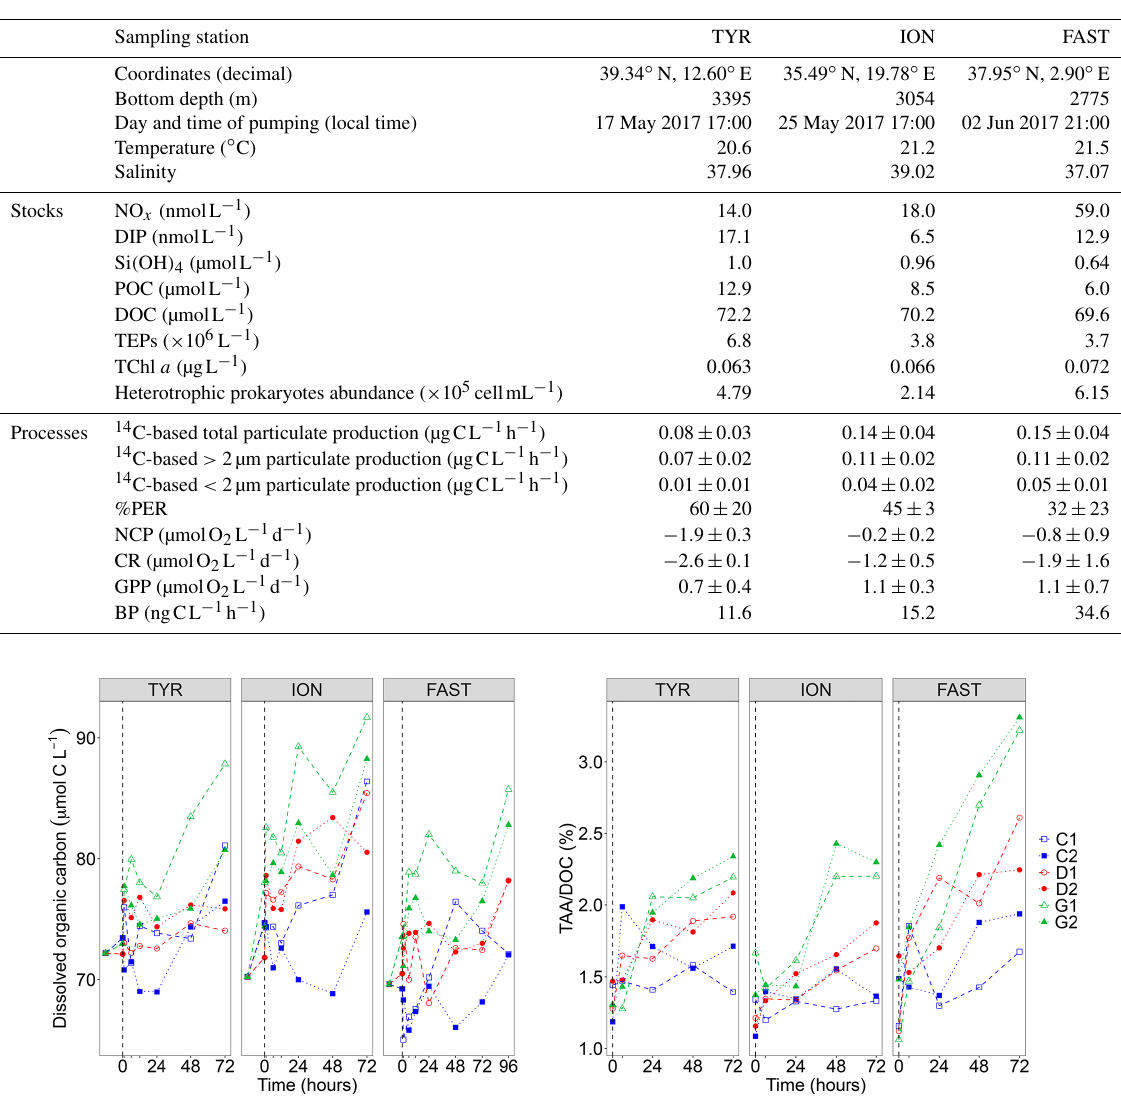
Figure 2. Dissolved organic carbon (DOC) concentrations and ratio between total hydrolysable amino acids (TAA) and DOC concentrations measured in the six tanks (controls: C1, C2; dust addition under present conditions of temperature and pH: D1, D2; dust addition under future conditions of temperature and pH: G1 and G2) during the three experiments (TYR, ION and FAST). The dashed vertical line indicates the time of seeding (after t